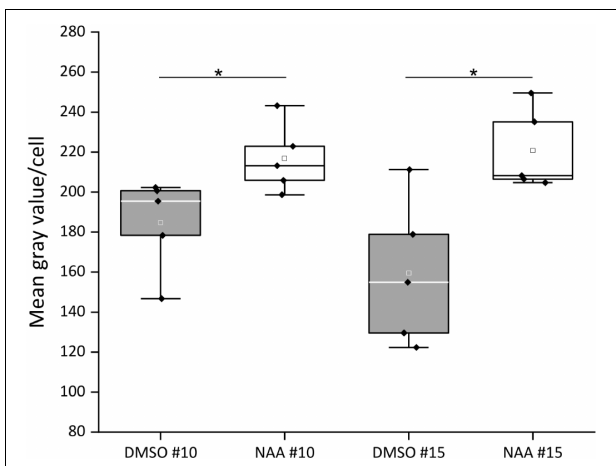
FIGURE 7 | Quantification of CTPS2::GFP fluorescence intensity in trichoblasts after 1-naphthaleneacetic acid (NAA) application. Five-day-old seedlings, grown on 1/2 Murashige–Skoog (MS) agar plates, were transferred to 250 nM NAA or control [dimethyl sulfoxide (DMSO)] plates for 20 h. The fluorescence intensity of roots from five seedlings per treatment with10 cells per analyzed root is represented in box plots. White and gray rectangles represent mean value in DMSO and NAA-treated plants, respectively. Median is shown as white or black line in DMSO or NAA box plot, respectively. Asterisks indicate statistically different data (Student’s t test, p <